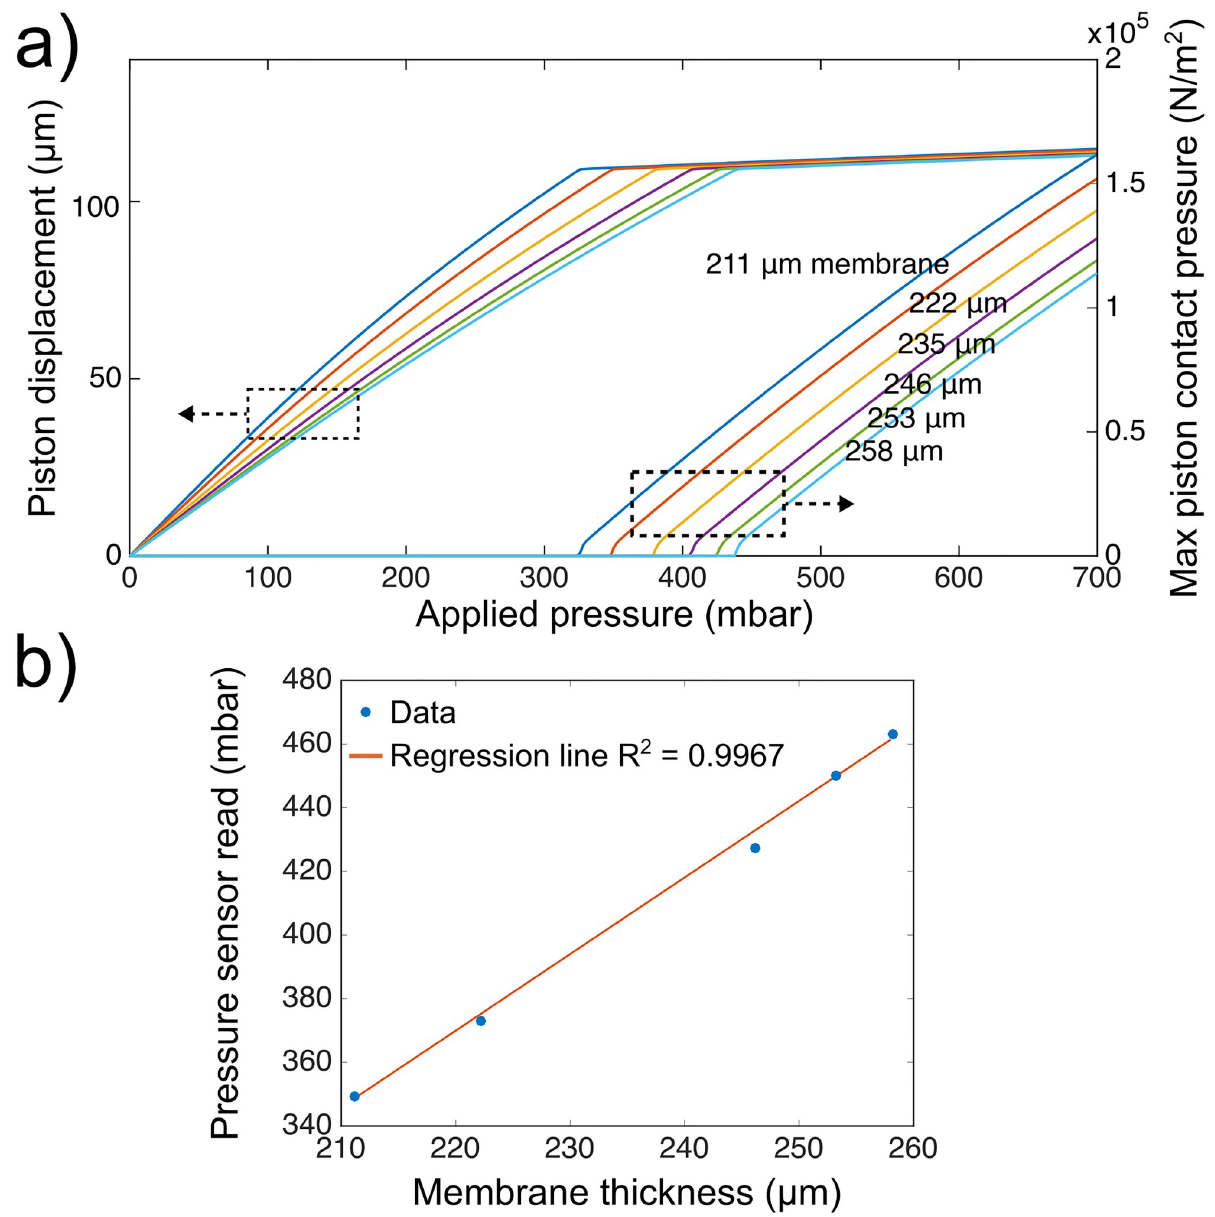
Fig 2. Computational and experimental validation of the micro-piston contact pressures across different membrane thicknesses. (a) Simulated piston displacement and maximum piston contact pressures at different membrane thicknesses as function of applied pressure. The left pattern of curves refers to the left y-axis (piston displacement ( μ m)), while the curve pattern on the right refers to the right y-axis (max piston contact pressure (N/ m 2 )), resulted at each externally applied pressure shown in x-axis. At a certain applied pressure (x-axis), micro-piston moves towards the bottom substrate and thus shows a displacement (left y-axis) depending on membrane thickness and applies a corresponding contact pressure (right y-axis). Colors of the curves refers to the membrane thicknesses indicated on the graph. (b) Correlation among independent experiments with the pressure sensor read for the externally applied pressures applied based on simulations in (a) run for the corresponding membrane thicknesses, resulting in a similar piston contact pressure.